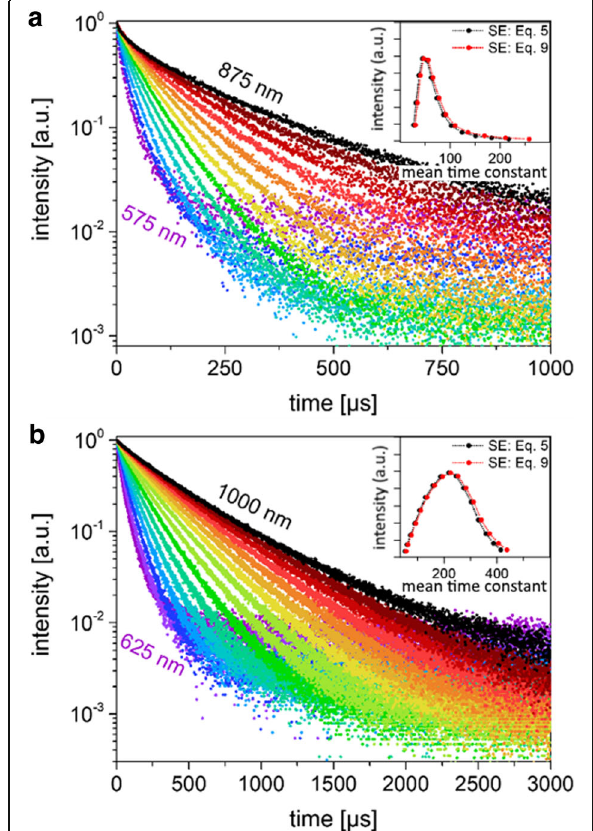
Fig. 5 Narrow-wavelength PL decays. a Luminescence decays for the small SiNCs at specific emission wavelengths (3 nm FWHM) ranging from 575 to 875 nm, in 25-nm intervals. The data were fit with Eqs. 5 and 9, which yielded a nearly single exponential fit. b Luminescence decays at specific emission wavelengths ranging from 625 to 1000 nm for the large SiNCs measured and fitted under the same conditions. The resulting time constants for the small and the large SiNCs are given in Table